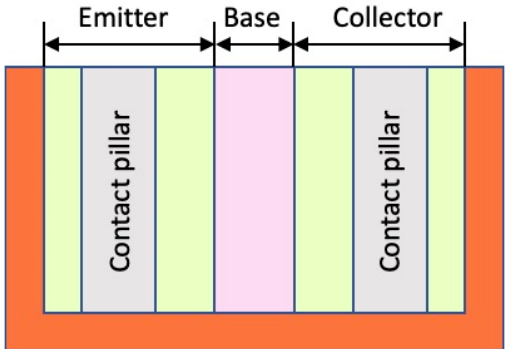
Figure 2. Cross-section along the diagonal of the elementary cell, with the bipolar junction transistor in VESTIC technology (green—polycrystalline emitter and collector, pink—base region, orange— insulating silicon dioxide, grey—the contact metal pillars).